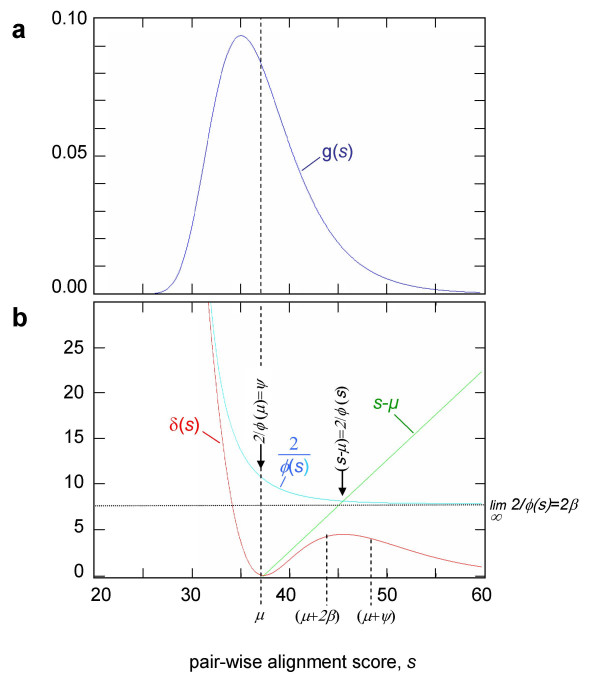
(A) Gumbel score distribution simulated for enolases used in the present paper (B) graphical determination of ψ